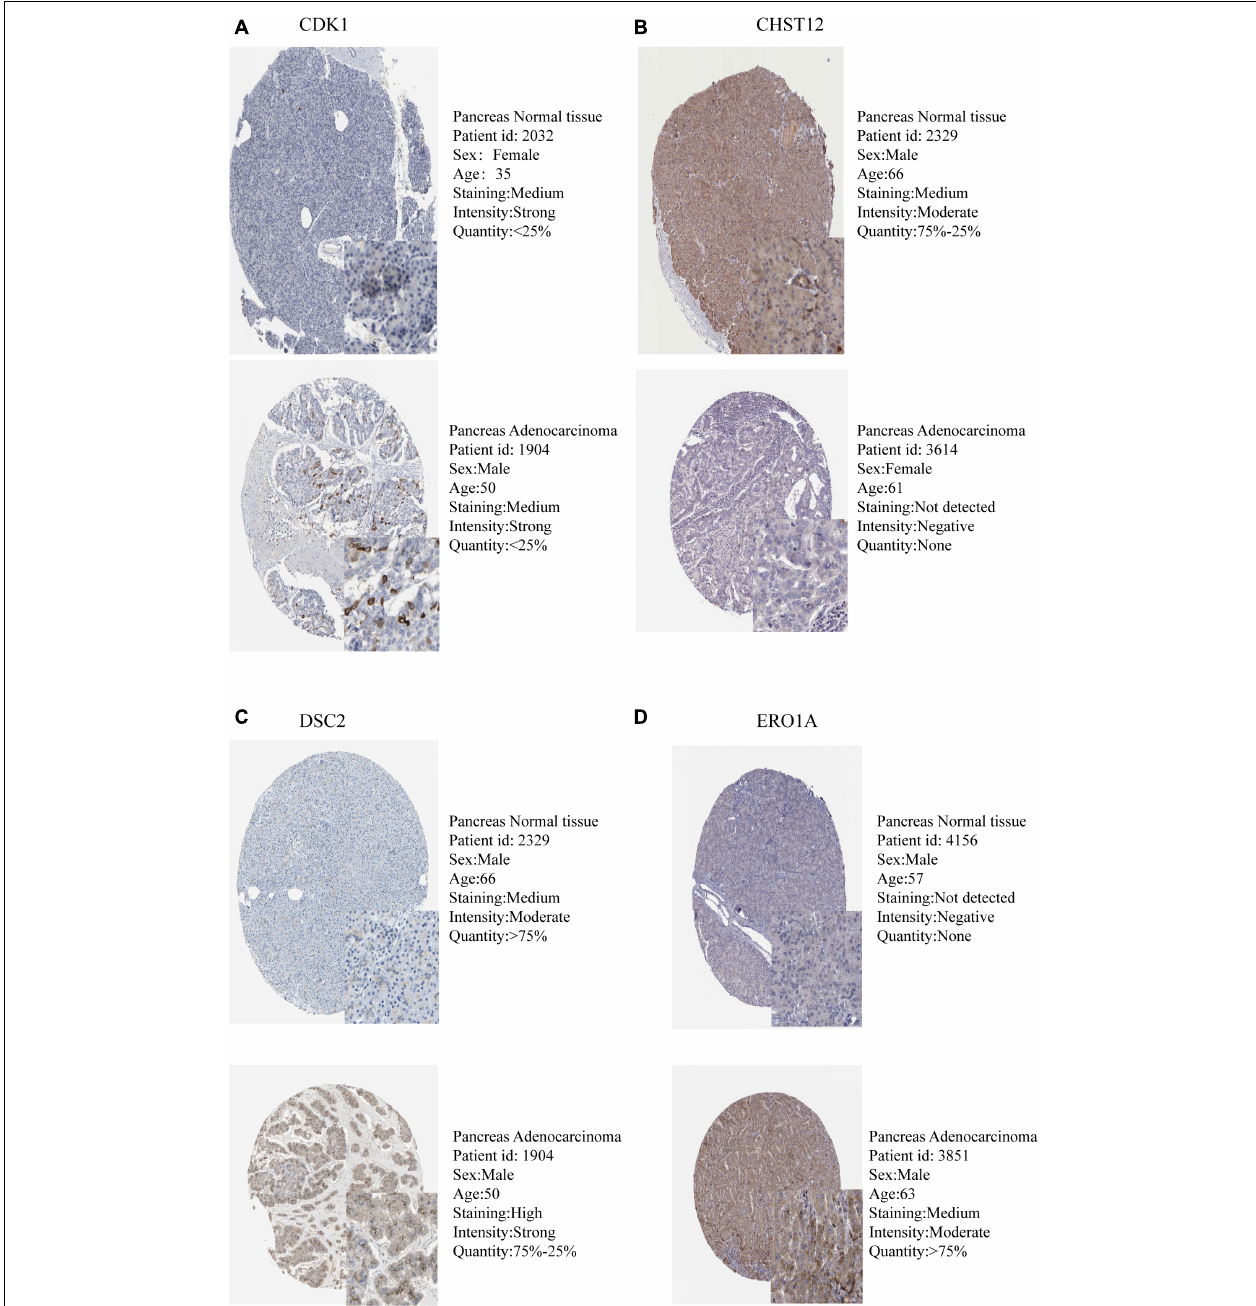
FIGURE 6 | Validation of model GRGs IHC images obtained from the Human Protein Atlas database (A–D)